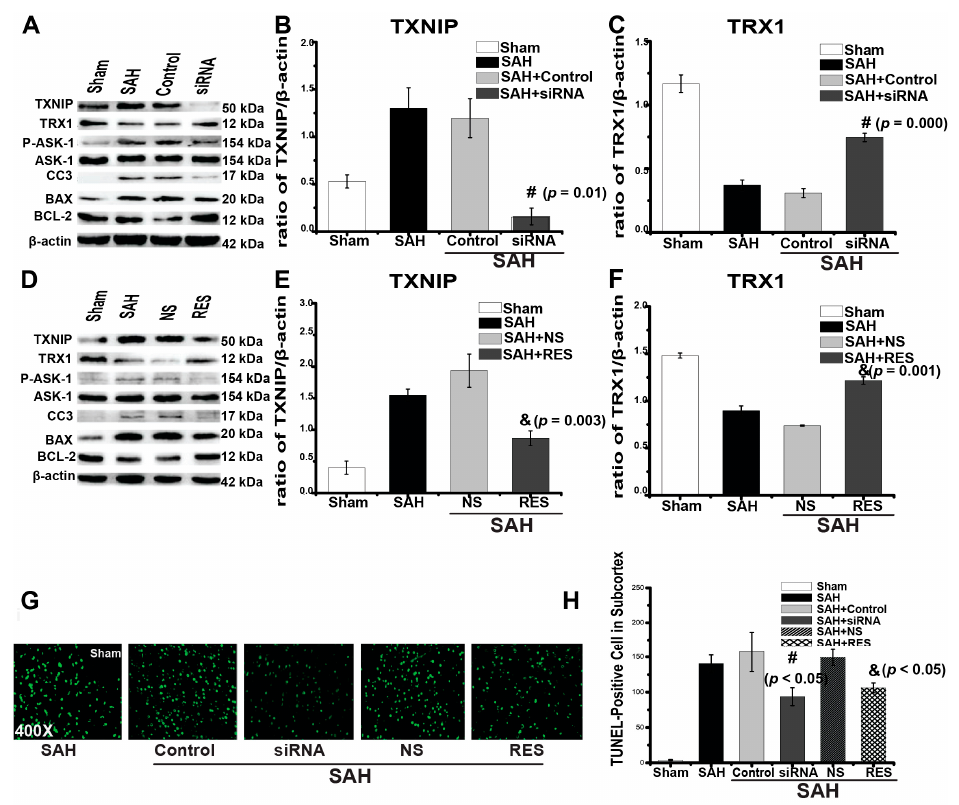
Figure 4. TXNIP and apoptosis protein expression, and the number of TUNEL-positive cells after TXNIP siRNA and RES treatment. ( A – F and Figures S1 and S2) Representative western blot and densitometric quantification of protein band optical densities for TXNIP, TRX1, p-ASK-1/ASK-1, CC3, BAX, and BCL-2. TXNIP and apoptosis protein expression levels were downregulated by TXNIP siRNA and RES treatment; ( G , H ) The number of TUNEL-positive cells decreased after siRNA and RES treatment. Original magnification, ×400; scale bars: G = 60 μ m. # p < 0.05 vs. SAH + control siRNA, & p < 0.05 vs. SAH + NS.